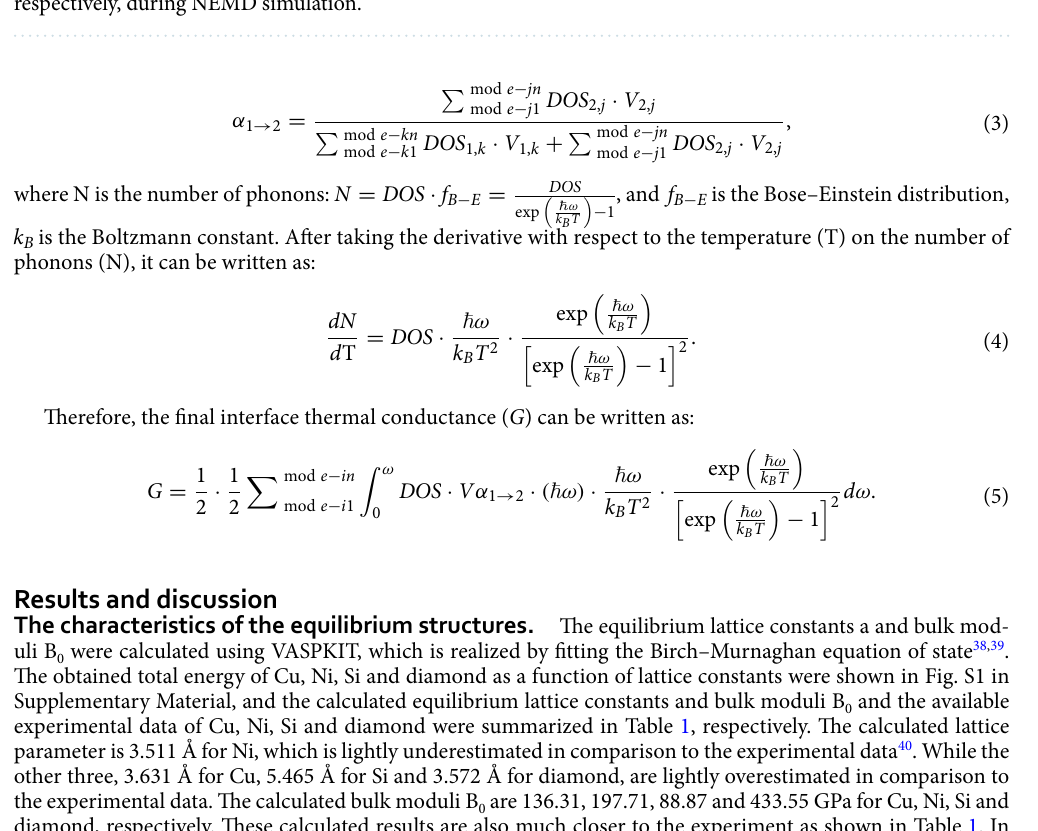
Figure 1. ( a ) Lattice structures of metal Ni or Cu and Si or diamond (left and top). ( b ) Type I, Type II and Type III for Ni–Si interface (left and bottom). ( c ) Relationship for Cu, Ni, Si and diamond between free energy and unit cell volume from 100 to 1000 K with a step of 100 K, respectively. (Right) And ( d ) Side view of the Cu–C and Cu–Si interfaces. The red rectangles with the width of 5 nm indicate heat source and sink regions, respectively, during NEMD